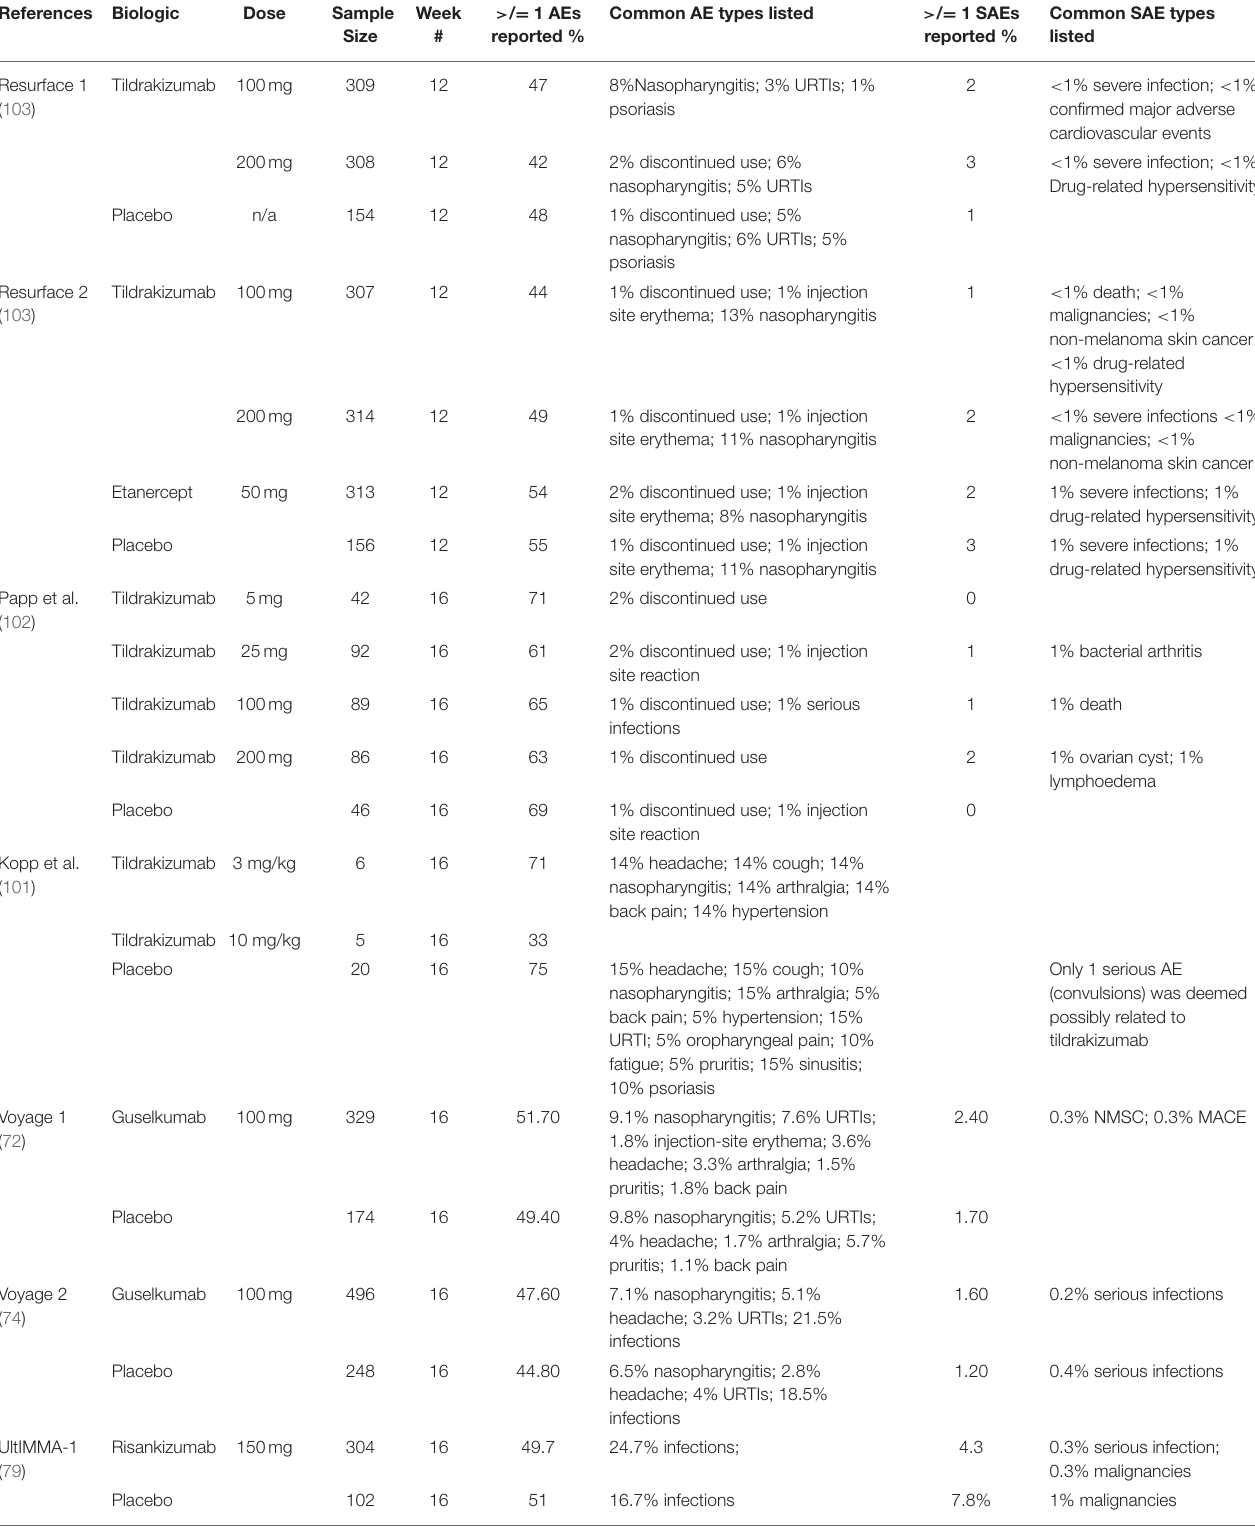
TABLE 3 | Summary of AEs and serious AEs that occurred in clinical trials evaluating the efficacy and safety of IL-23, IL-23/12, IL-17, and TNF- α